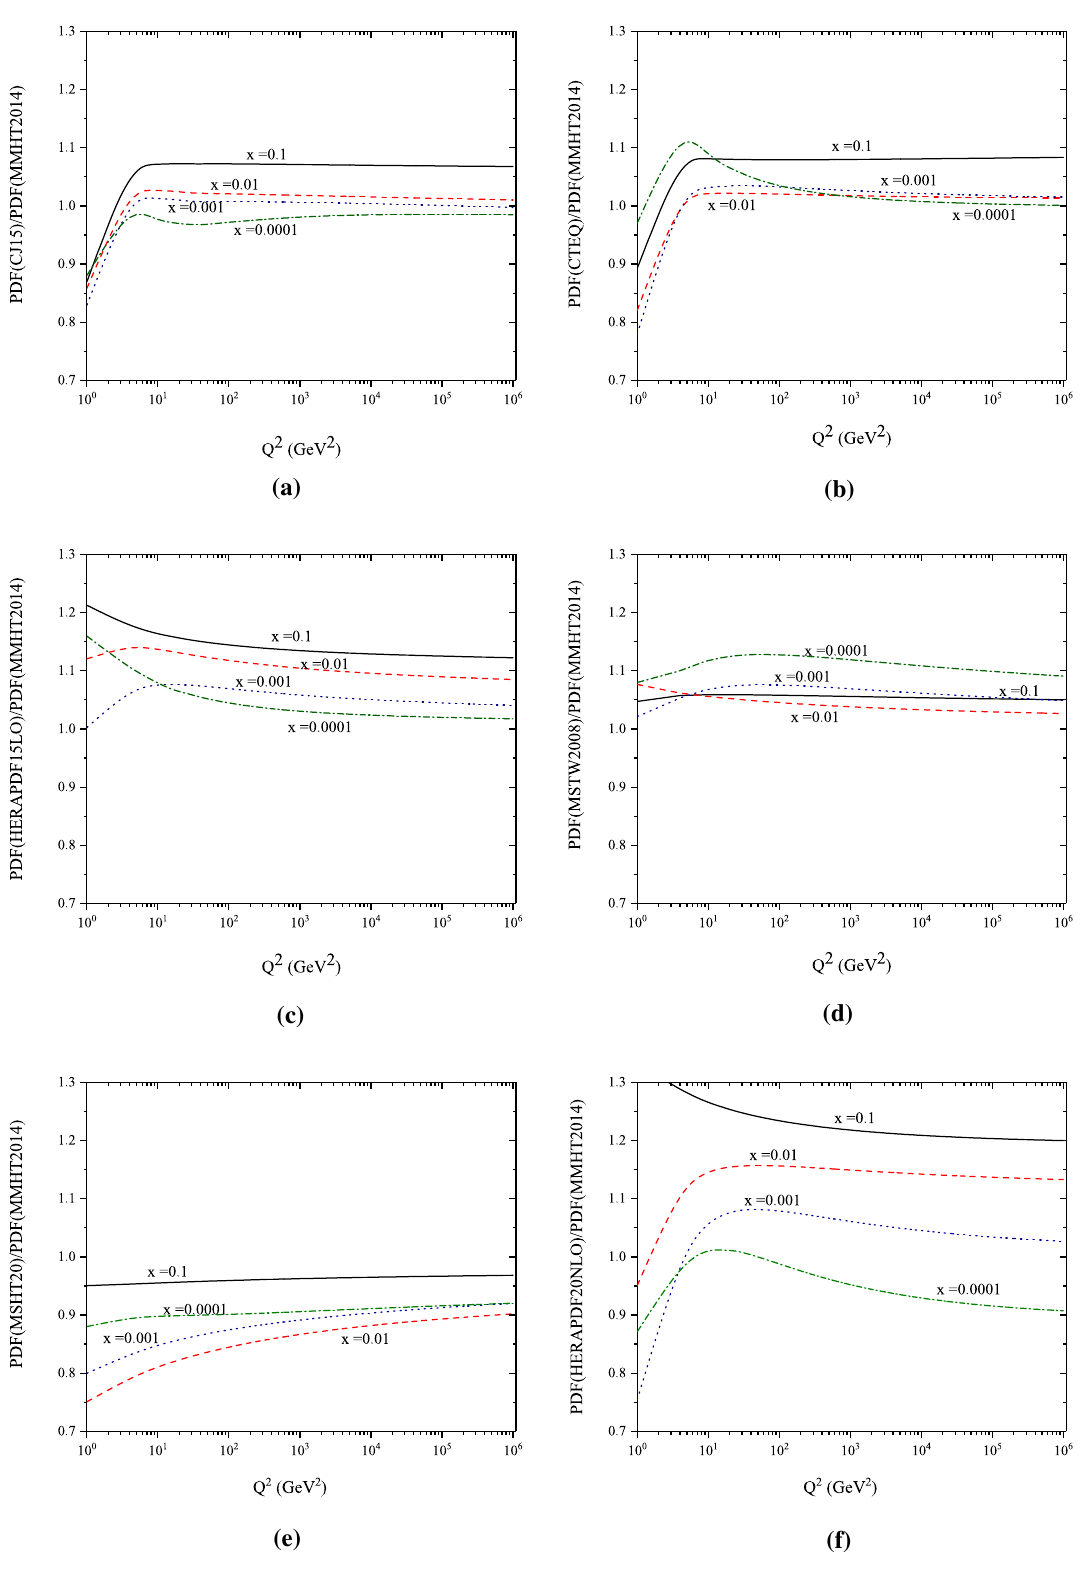
Fig. 1 The different up-quark PDFs ratios for various x values given in the panels a –